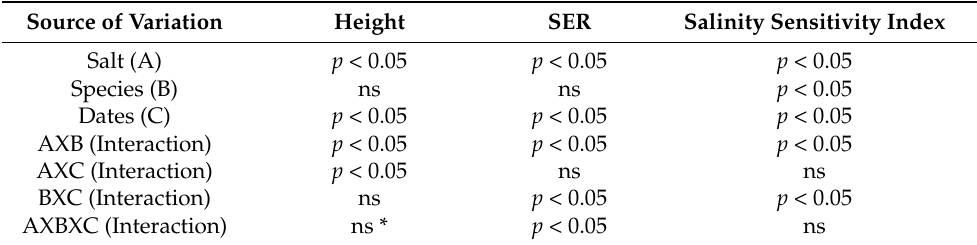
Table 1. Statistical significance of F ratios from the analysis of variance for stem height of seedlings, stem elongation rate (SER) and sensitivity index. Source of Variation Height SER Salinity Sensitivity